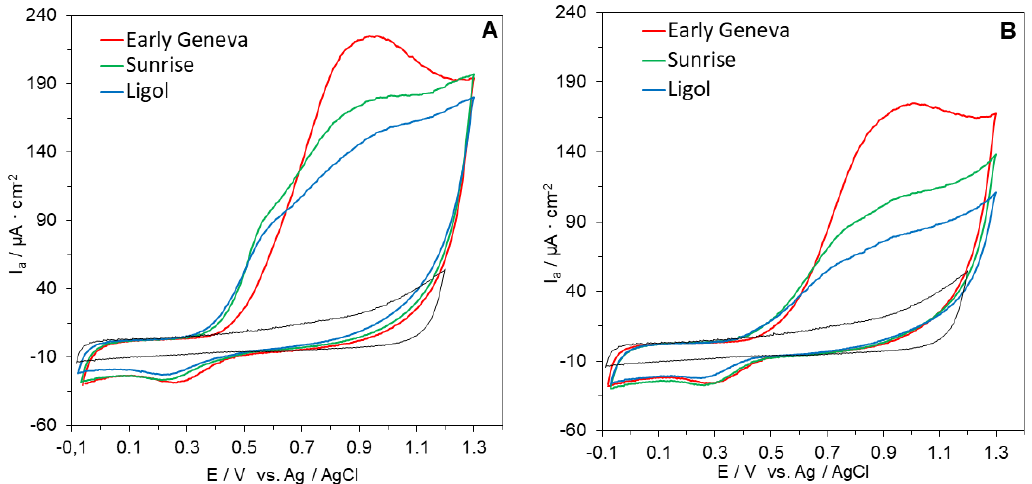
Figure 2. Cyclic voltammograms of selected apple cultivars: ( A ) extracts from peel; ( B ) extracts from flesh. CV of electrolyte solution shown as dotted gray line. Operative conditions: extract concentration 25 mg / mL; pH 6.0; scan rate 0.1 V /